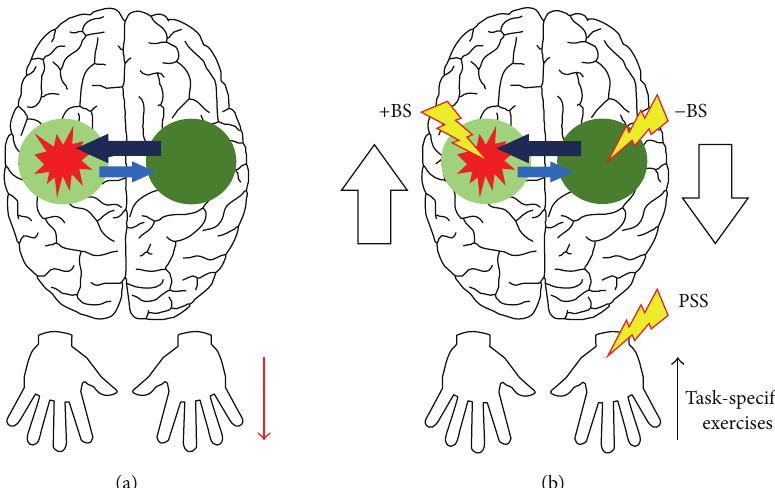
Figure1:Thisfigureillustratestheinteractionbetweentwoprevailingtheoriesofmotorrecoveryafterstroke,namedhereasthe“reactivation” and “rebalancing” theories (a), and some of the contemporary motor rehabilitation strategies for treating poststroke upper limb hemiparesis that have been largely underpinned by these theories (b). Red explosion-like balloon : hemiparetic stroke. Light green circle : depression, that is, decreased size and/or excitability, of residual cortical motor representations in the adjacent, perilesional tissue. Dark green circle : overactivity of homologous cortical motor representations in the opposite, undamaged cerebral hemisphere. Light blue arrow : decreased transcallosal inhibition. Dark blue arrow : increased transcallosal inhibition. Red thin downward arrow : reduced use of the paretic upper limb contralateral to the stroke side. Black thin upward arrow : increased skilled use of the paretic upper limb through physiotherapy in the form of task-specific exercises. Red-yellow bolts : adjunctive therapies, such as excitatory and inhibitory brain stimulation (+BS and − BS, resp.) and peripheral somatosensory stimulation (PSS), to be combined with physiotherapy exercises. White tick upward arrow : increase activity in the ipsilesional motor cortex. White tick downward arrow : decrease activity in the contralesional motor cortex. See text for further